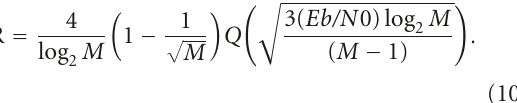
Figure 14: BER versus E b /N 0 for 16, 64, 256-QAM in permitted ranges of amplitude error. From left to right: 16-QAM: ε = 0,0 . 12, 64-QAM: ε = 0,0 . 03, 256-QAM: ε = 0,0 . 014.